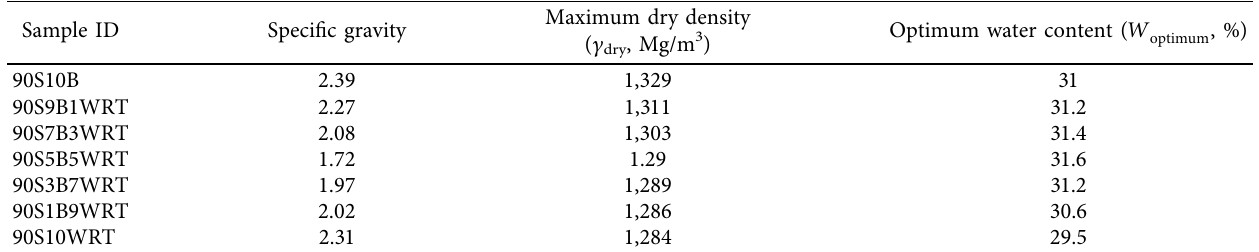
Table 4: Physical characteristics of the